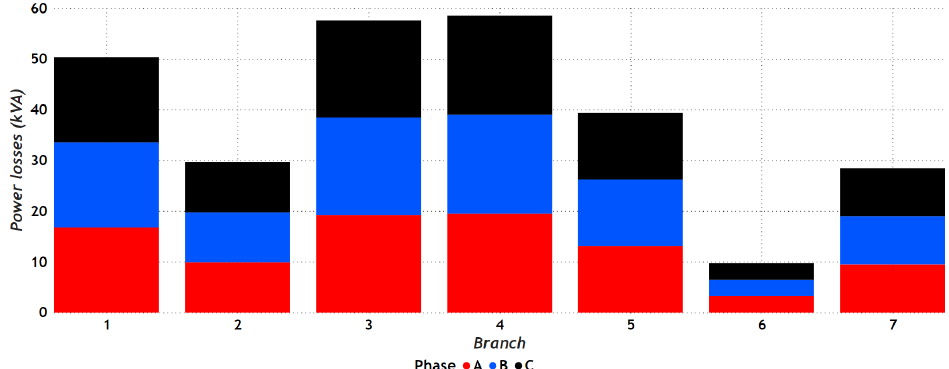
Figure 7. Power losses present in the branches of the three-phase 8-bus distribution system under a balanced load